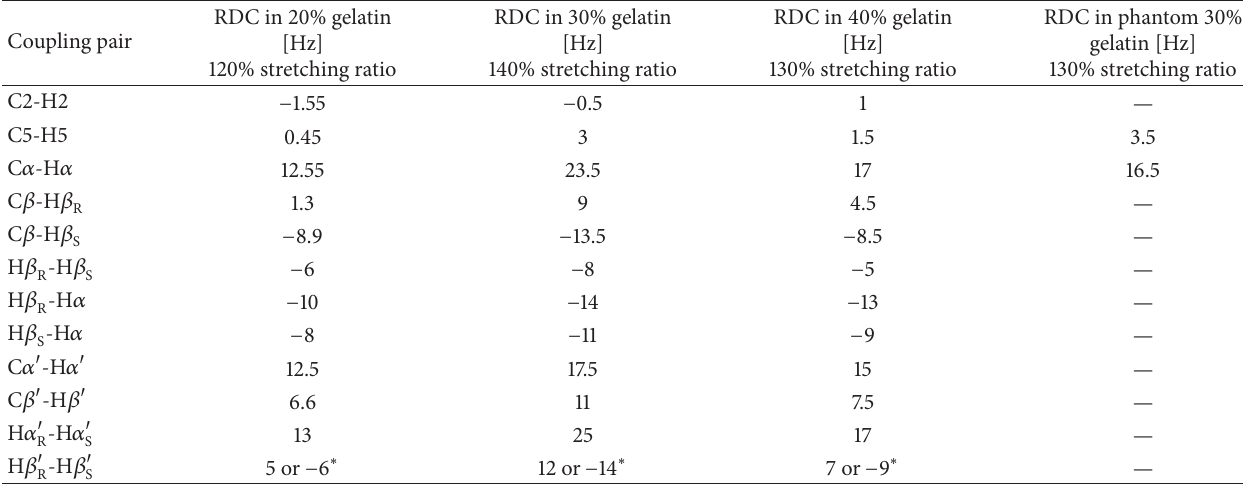
∗ It was not possible to achieve unambiguous determination; both values provide identical spectral pattern.